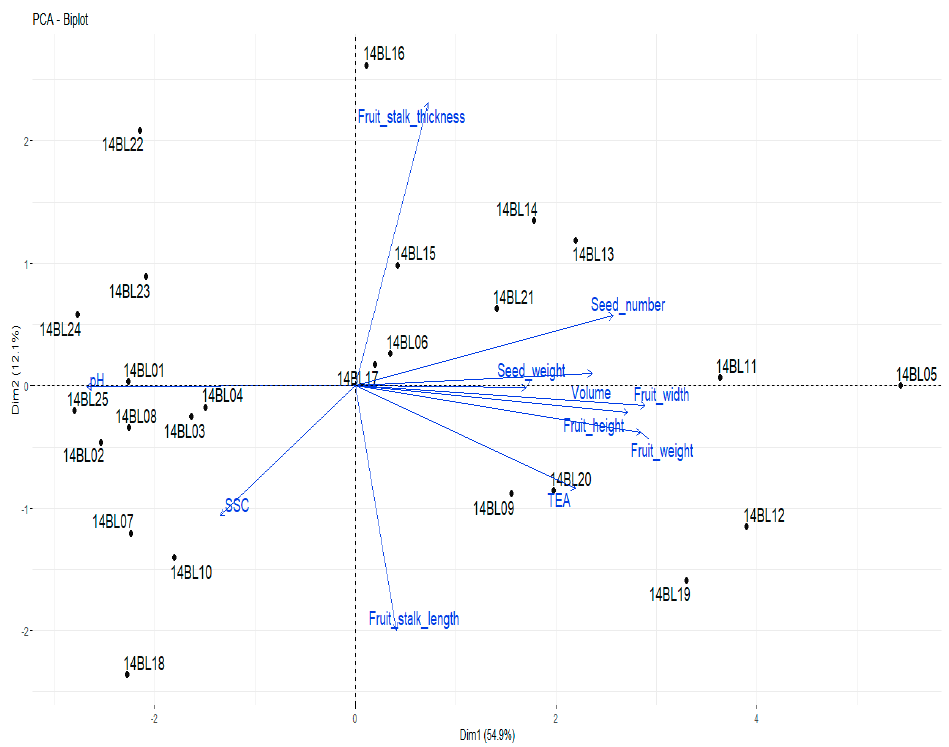
Figure 3. Diversity of genotypes in terms of fruit traits by PCA analysis. Table 5. Fruit color values of hawthorn genotypes.